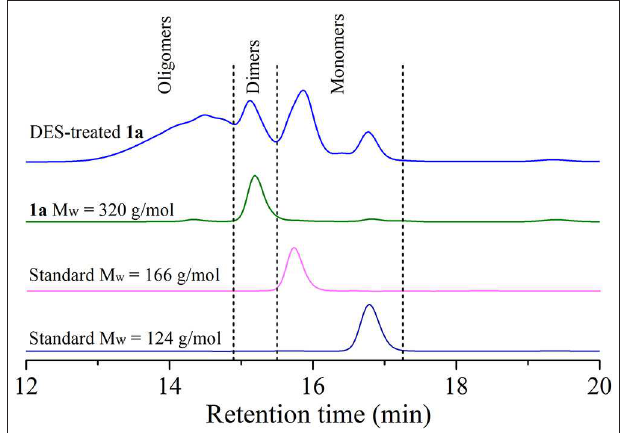
FIGURE 5 | Gel permeation chromatography (GPC) spectra of deep eutectic solvent (DES)-treated 1a , compound 1a and standard compounds [guaiacol: